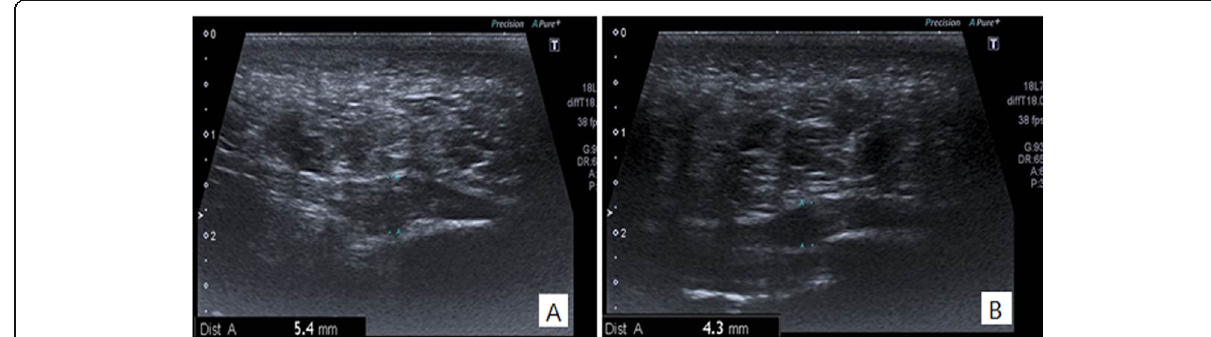
Fig. 4 Longitudinal sonogram of a 40-year-old-female patient showing (A) increased Right PF thickness before ESWT (5.4mm) and (B) reduction to (4.3 mm) after